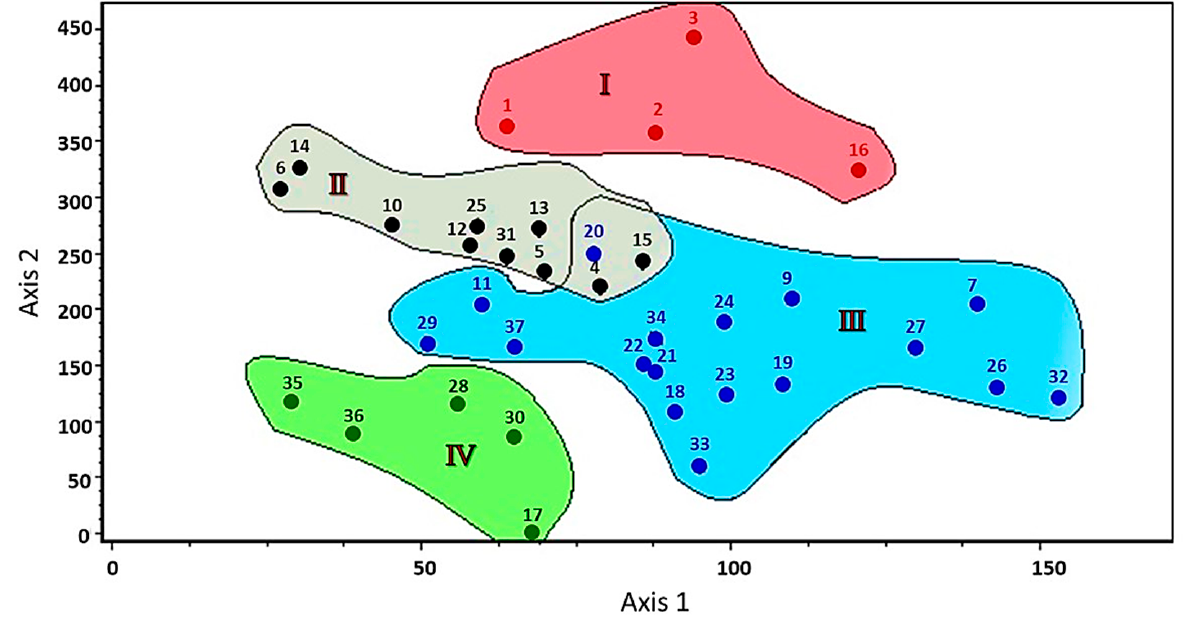
Figure 3. Detrended Correspondence Analysis (DCA) ordination diagram of the 37 stands with vegetation groups of the Deltaic Mediterranean coastal area (Dakahlia Governorate). The stands were numbered from 1 to 37 and represented by “ ● ”.